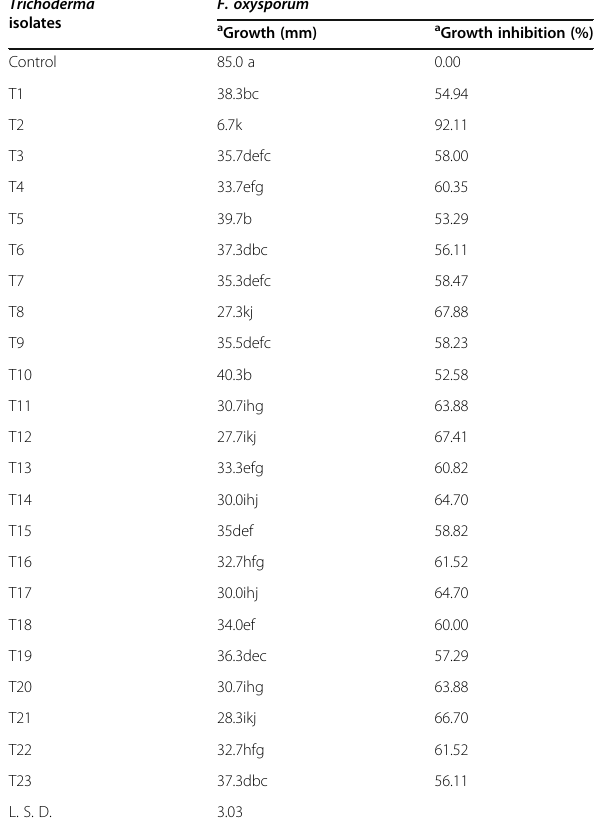
Table 2 Antagonists effect of Trichoderma isolates on the growth of F. oxysporum under in vitro